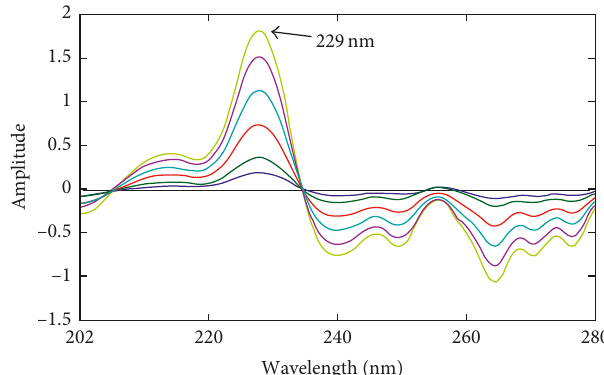
Figure 5: Ratio spectra of laboratory-prepared mixtures of acli- dinium (5–40 µ g/mL) and formoterol (5–10 µ g/mL) using 8 µ g/mL of formoterol as a divisor.